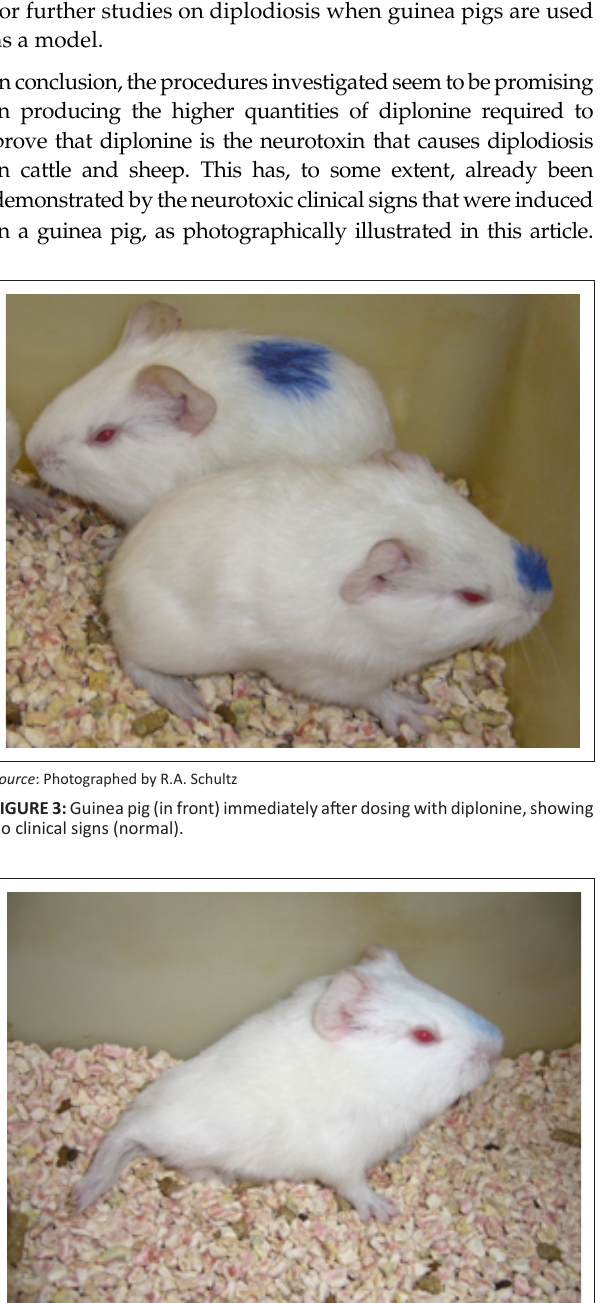
doi:10.4102/ojvr.v81i1.765http://www.ojvr.org